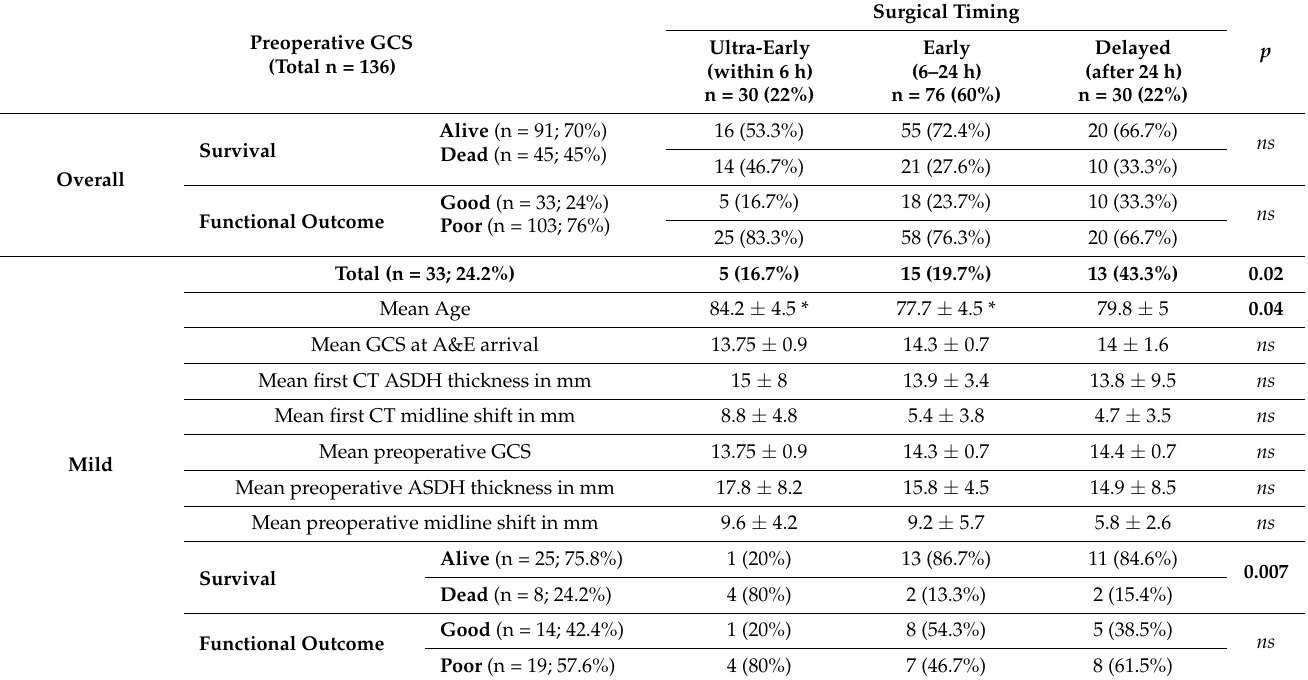
Table 2. Demographics and outcomes stratified by preoperative